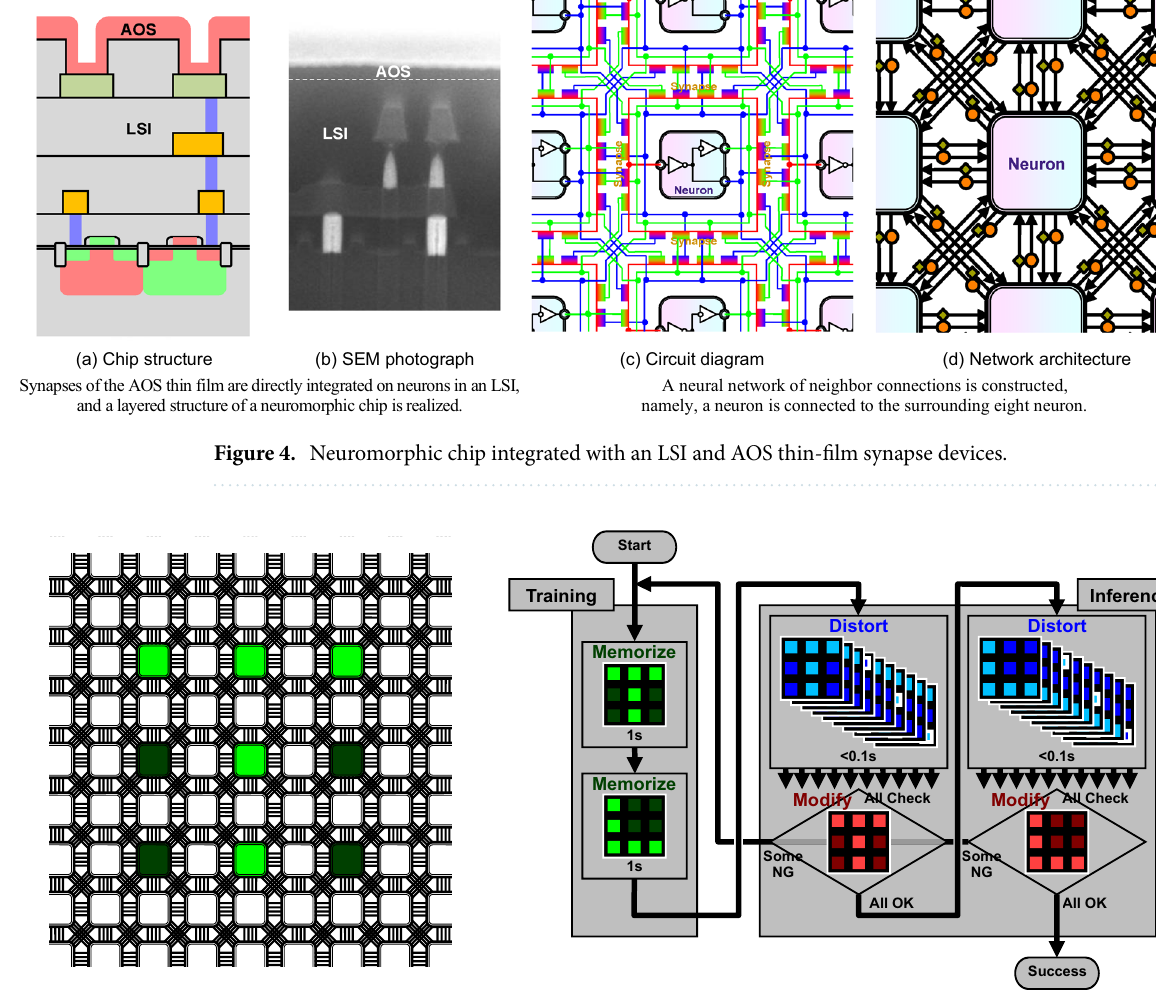
(b) Evaluation flowchart During the training, the voltage corresponding to the pixel signals is applied in sequence. During the inference, the voltage corresponding to those slightly distorted is applied, and it is checked that the modified patterns from the neuromorphic chip are the same as the memorized patterns Figure 5. Evaluation method as the associative